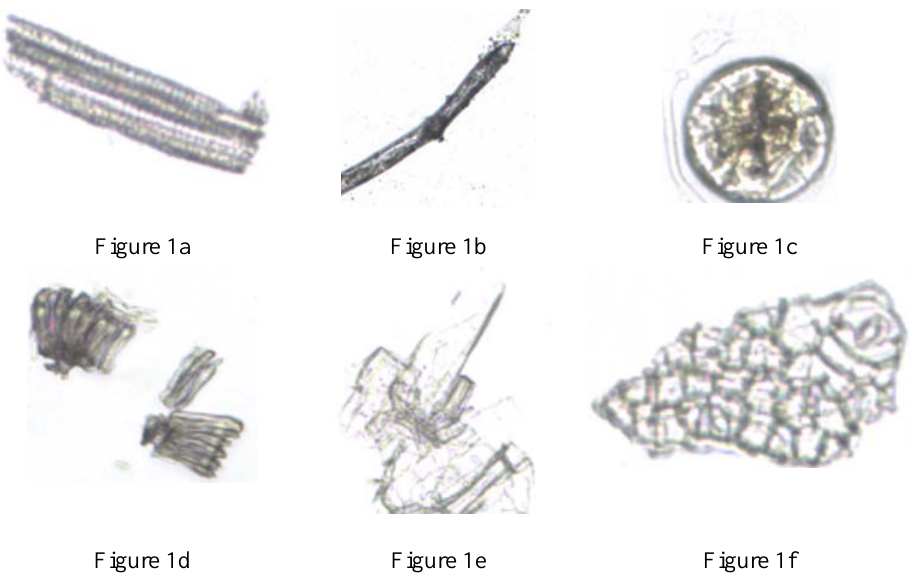
Figure 1. Powder microscopy A: Fiber, B: Non- glandular hairs, C: Pollen grain, D: Catheter E: stomata, F: palisade